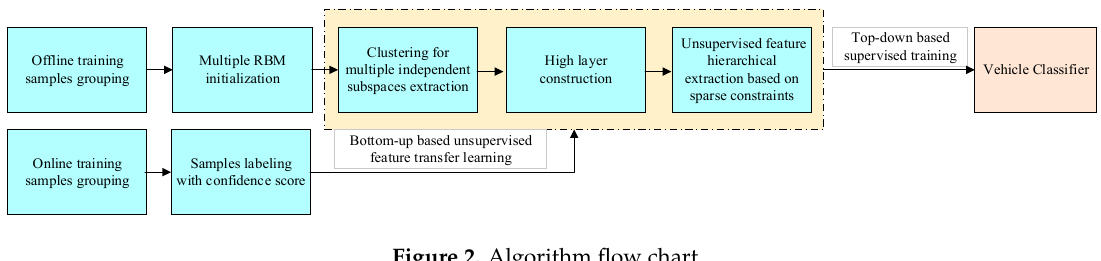
Figure 2. Algorithm flow chart.